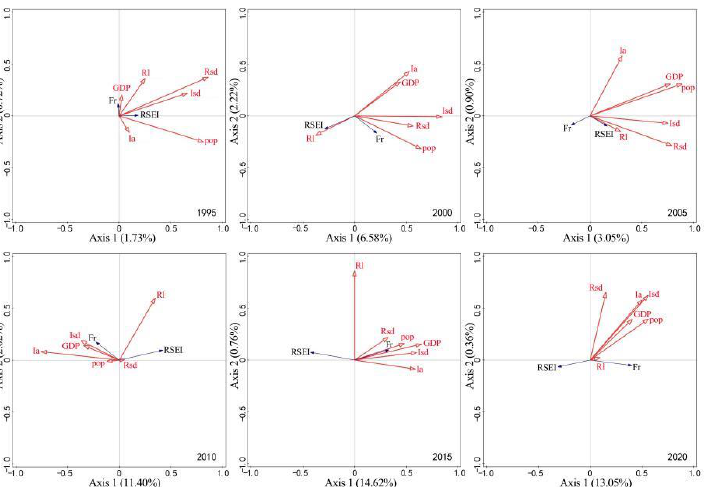
Figure 10. Correlation of RSEI and Fr with anthropogenic factors. Note: RSEI, Fr, pop, GDP, Rl, Rsd, Ia, and Isd respectively represent remote sensing-based ecological index, rock outcrop rate, population spatial distribution, GDP spatial distribution, road length, road surface density, impervious surface area, and impervious surface density; RSEI and Fr are response variables and the rest are interpretation variables.